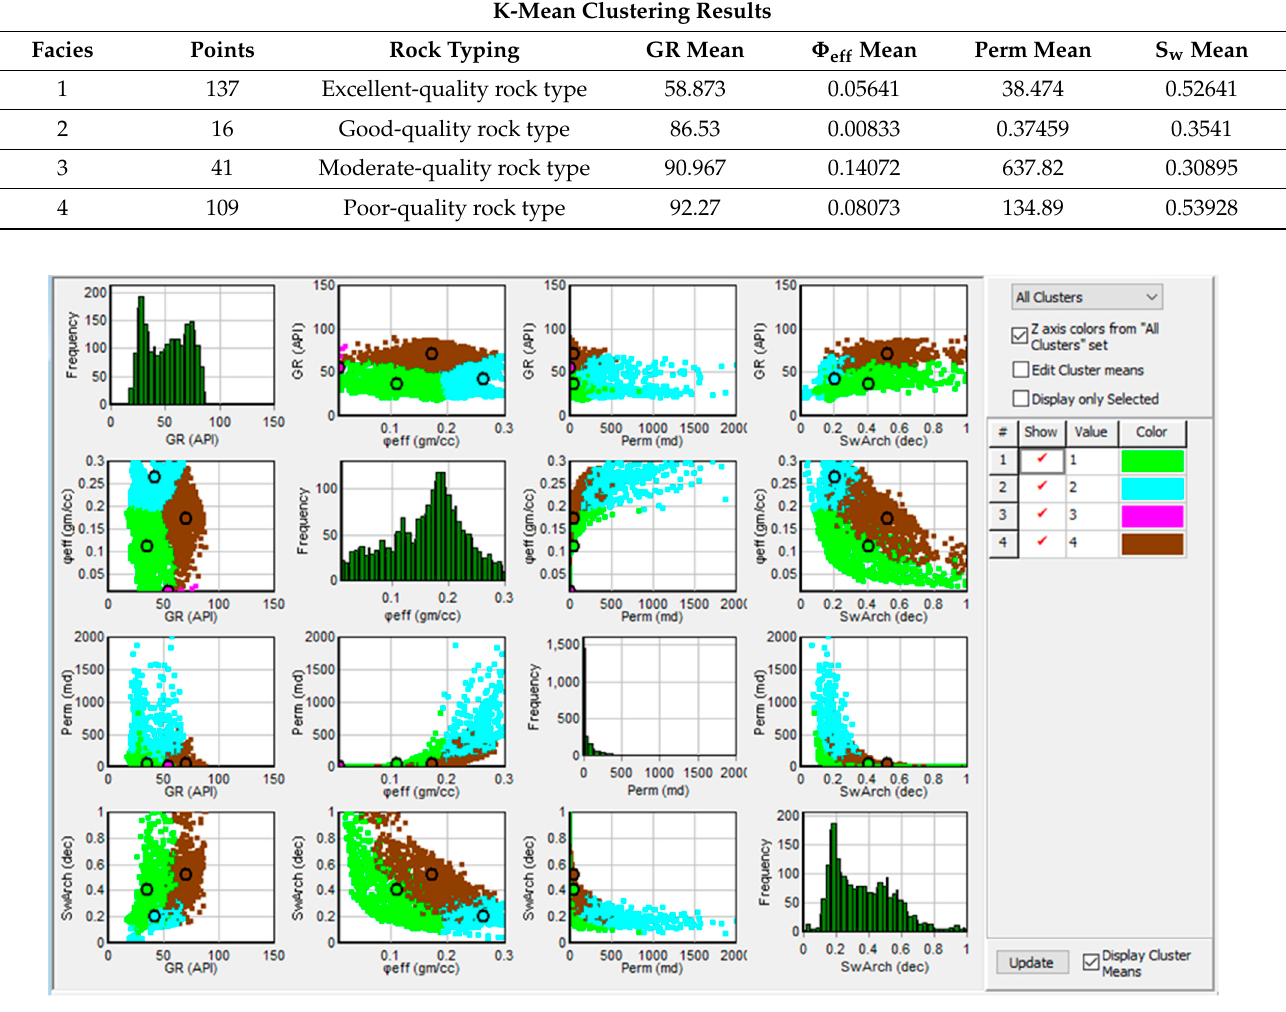
Figure 18. QGF-well 03 cluster analysis depicting the final result. Table 5. Detailed description of the features of log